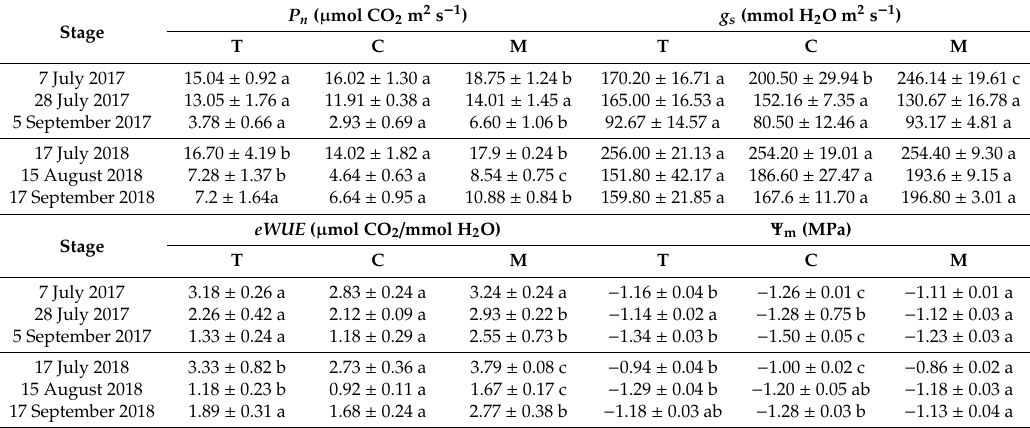
Table 1. Physiological parameters. Net photosynthesis ( P n ), stomatal conductance ( g s ), water use e ffi ciency ( eWUE ), and midday stem water potential ( Ψ m ) of V. vinifera treated with three di ff erent soil management practices. Measurements were conducted at full veraison, mid maturation, and full maturation. Data (mean ± SE, n = 10) were subjected to one-way ANOVA. Di ff erent letters within the same parameter and row indicate significant di ff erences among M, T, and C (Least Significant Di ff erence (LSD) test, p ≤